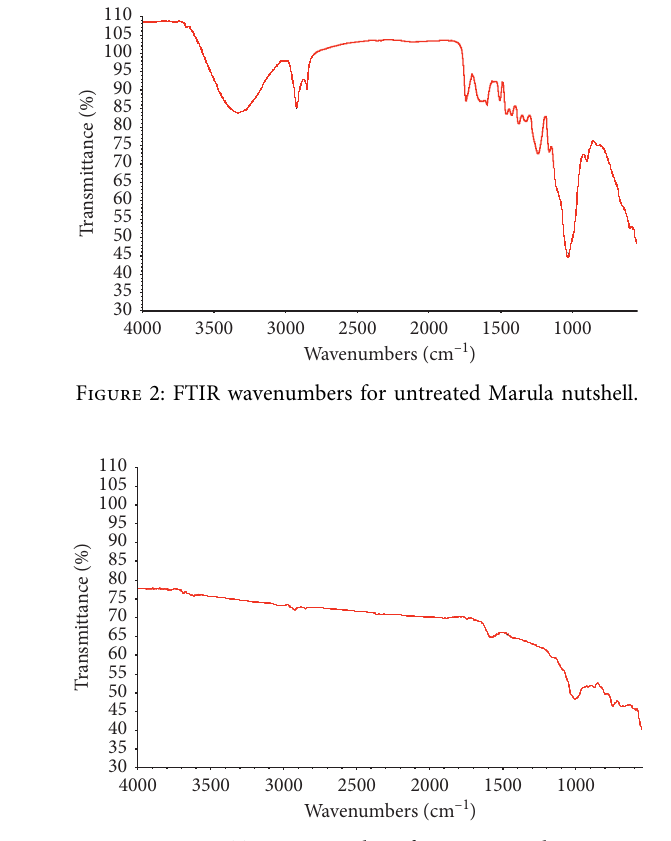
Figure 3: FTIR wavenumbers for commercial